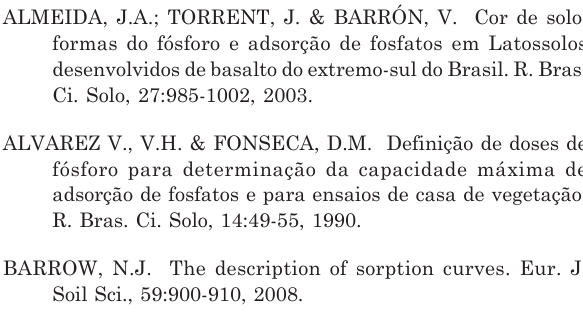
Figura 4. Teores de fósforo extraído com água após 20 dias de incubação de doses de fósforo em amostras com 200, 400, 600 e 800 g kg -1 de argila. Os valores indicados pelas setas representam a quantidade de fósforo adicionada em cada solo a partir da qual a taxa de liberação de fósforo para a água aumenta